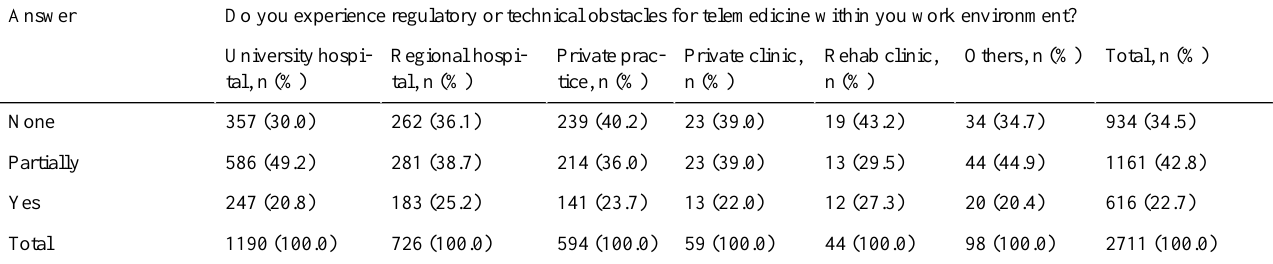
Table 4. Subcohort analysis: regulatory or technical obstacles for telemedicine within different work environments. Do you experience regulatory or technical obstacles for telemedicine within you work environment?Answer